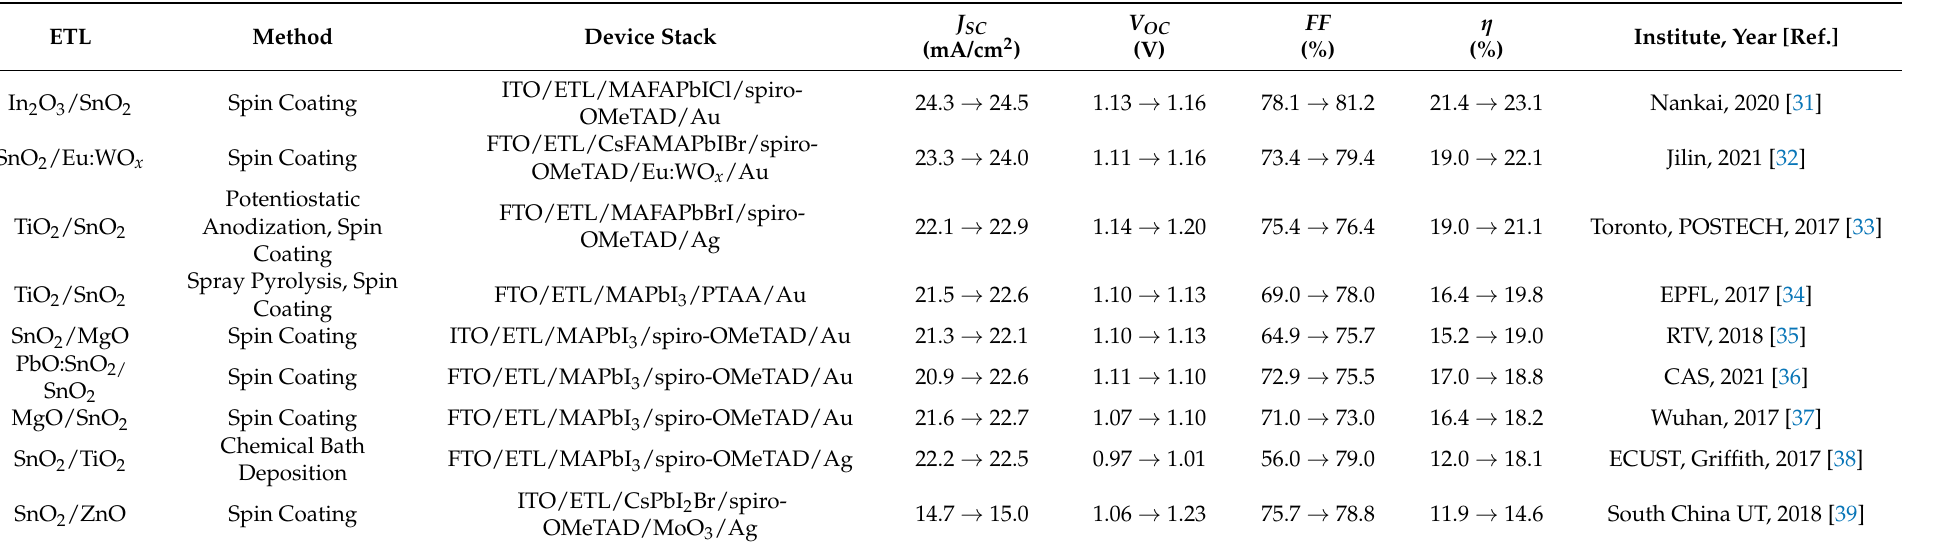
Table 2. Summary of perovskite-solar cells based on metal oxide modified SnO 2